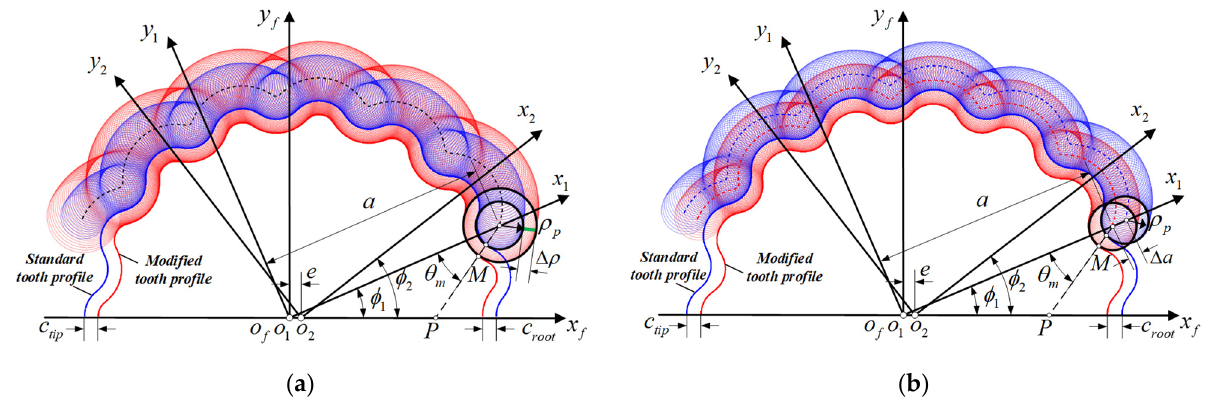
Figure 3. Coordinate systems for the tooth profile modification of cycloid gears: ( a ) pin radius modification; ( b ) pin position modification.